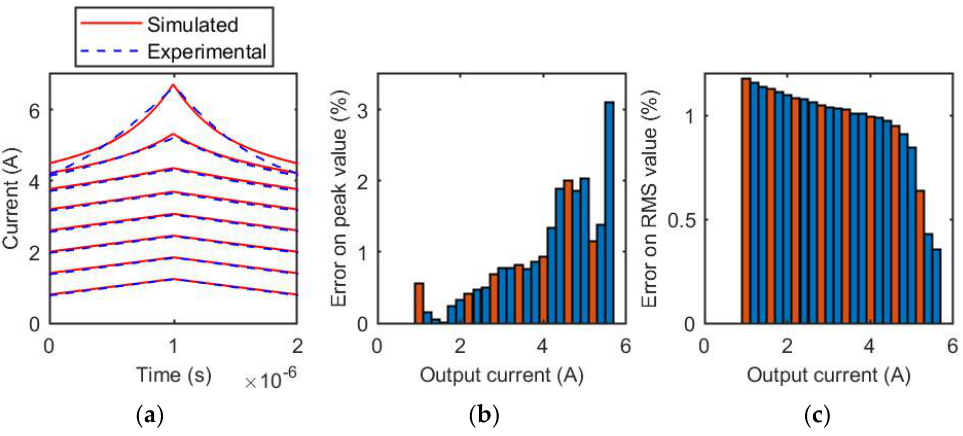
Figure 7. Coilcraft MSS1260T-273 inductor, 500 kHz. ( a ) Comparison of experimental and simulated current waveforms for different output current values; ( b ) relative error of the estimation of the peak value of the inductive current for each tested output current value. The orange bars represent the test cases reported in ( a ), the blue bars are related to the other measurements of the evaluated current range; ( c ) relative error of the estimation of the RMS value of the inductive current for each tested output current value. The orange bars represent the test cases reported in ( a ), the blue bars are related to the other measurements of the evaluated current range.